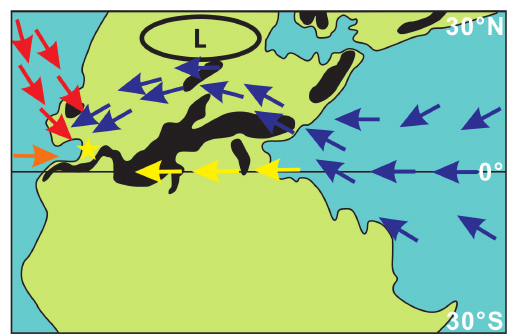
Figure 19. Paleogeographic reconstruction of late Carbonifer- ous–early Permian Pangaea (30 ◦ N–30 ◦ S). Black – highlands (1000m); blue arrows – monsoonal circulation; yellow arrows – zonal easterly flow in the ITCZ; red arrows – northwesterly exten- sion of westerlies (Tabor and Montañez,